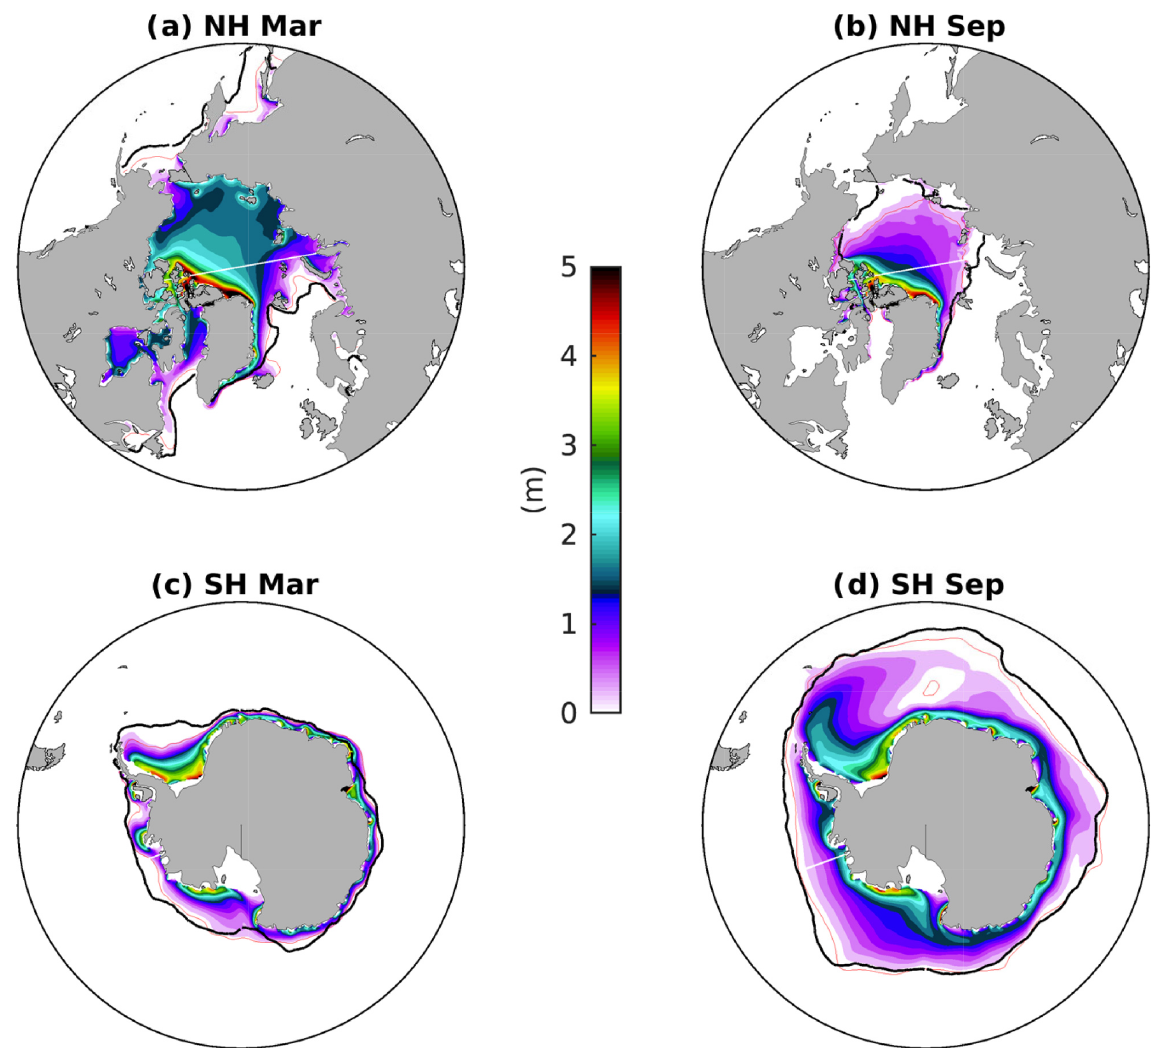
Figure 8. Simulated historical sea ice thickness (shading; m) averaged over the years 1976–2005 for (a) NH March, (b) NH September, (c) SH March, and (d) SH September. The red lines show the modeled mean 15% sea ice concentration, and the thick black lines show the same from the Hadley Centre Sea Ice and Sea Surface Temperature data set (HadISST; Rayner et al., 2003) for the same